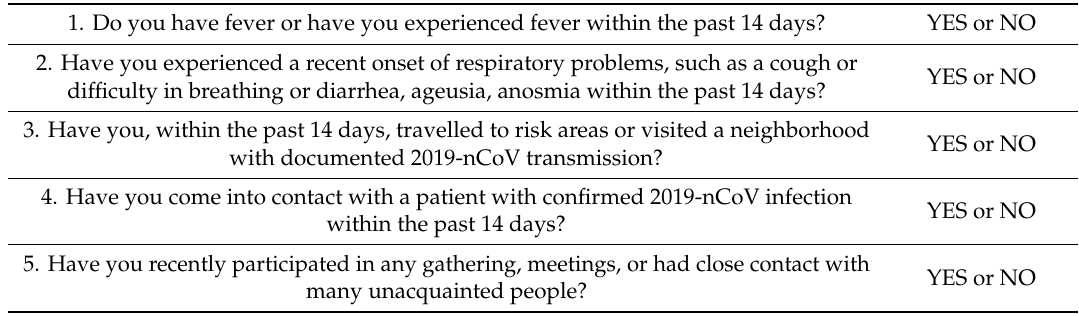
Table 1. COVID-19 screening questionnaire.